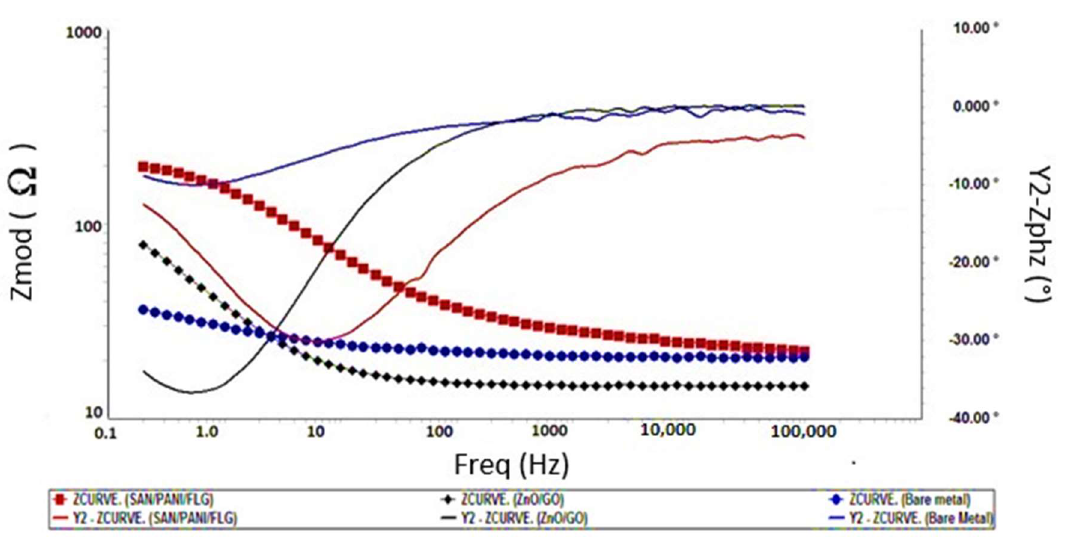
Figure 3. Nyquist Plots of bare and coated samples seawater.